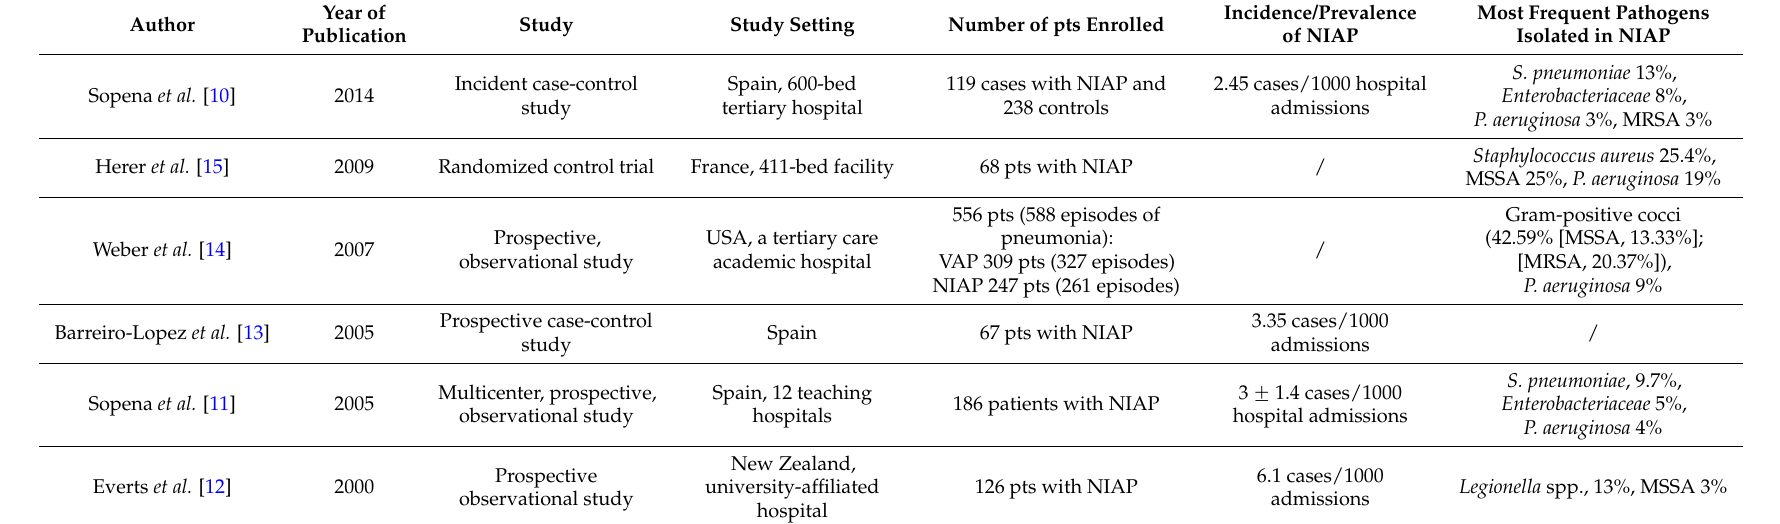
Table 1. Available literature on non ICU-acquired pneumonia (NIAP).